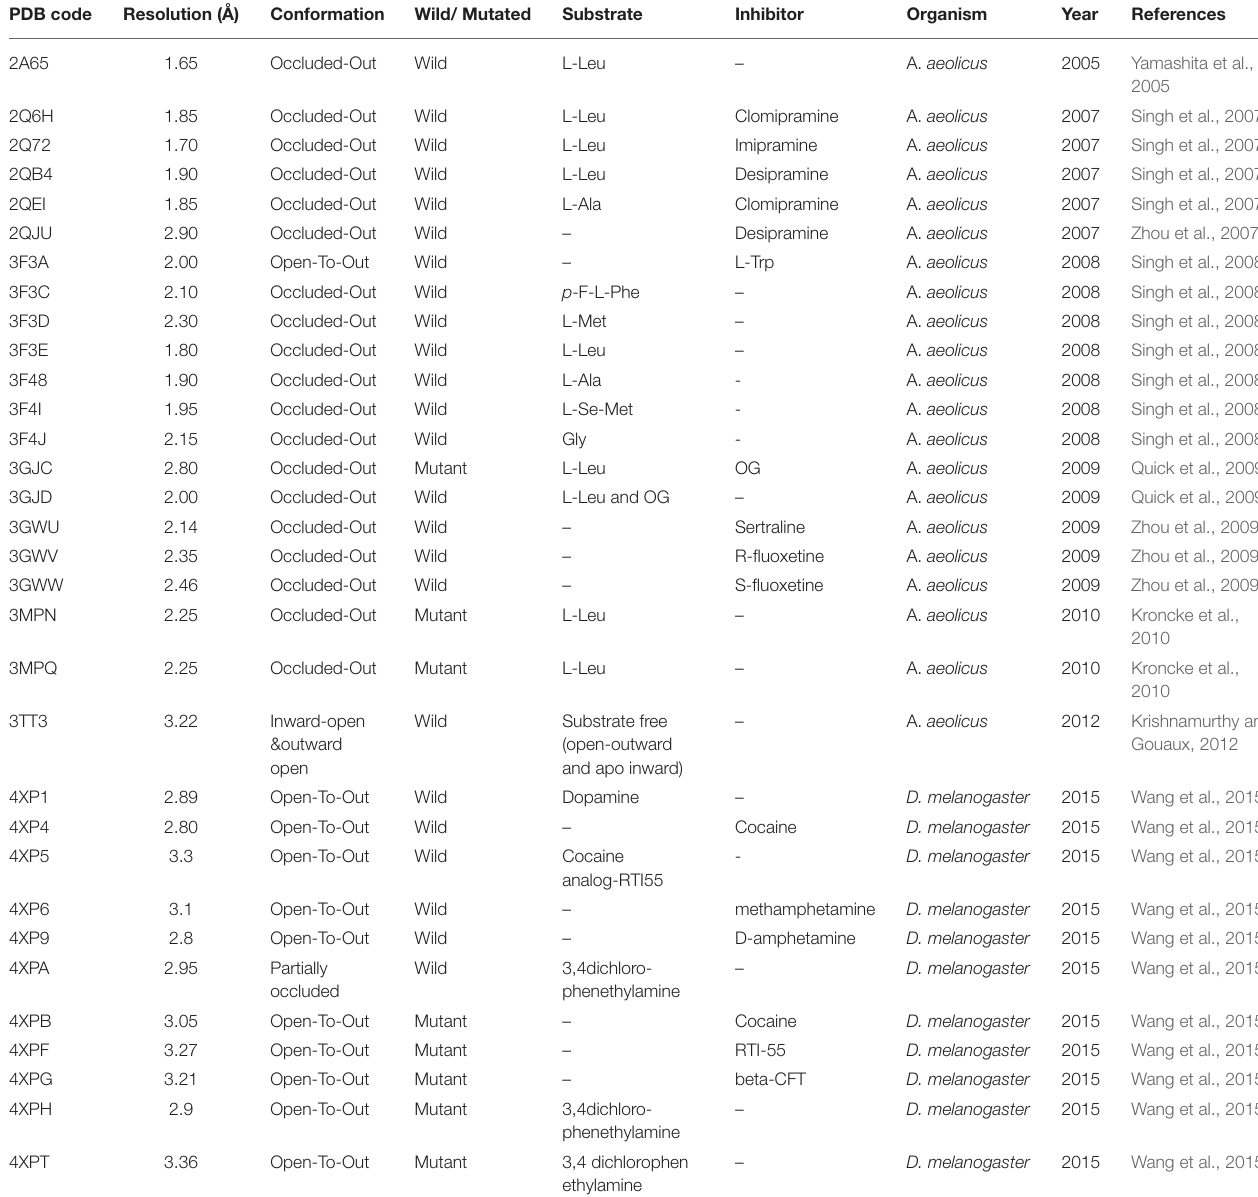
TABLE 1 | Reported crystal structures of Aa LeuT and dDAT deposited in RCSB PDB. PDB code